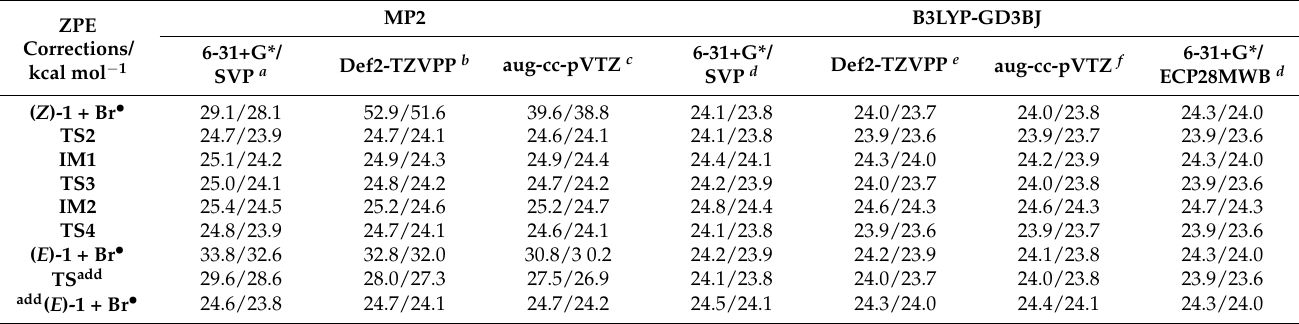
Table 1. Unscaled/scaled MP2 and B3LYP ZPE values for bromine radical attack to the “bromine end”. ZPE Corrections/ kcal mol −